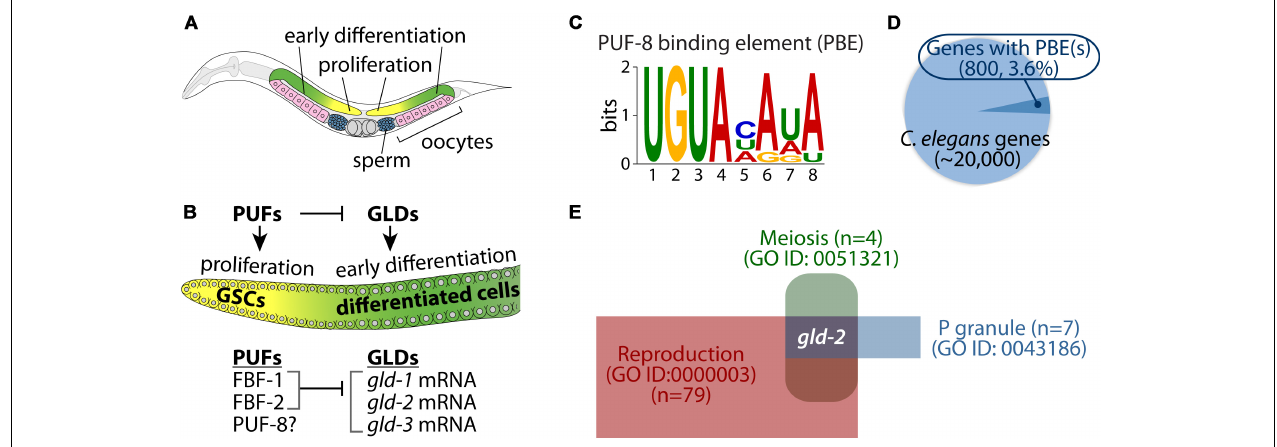
FIGURE 1 | Caenorhabditis elegans germ line and PUF-8 RNA-binding protein. (A) Schematic of an adult C. elegans hermaphrodite gonad. Cells at the distal end of the germline include germline stem cells (GSCs) and proliferative cells (yellow). As cells move proximally, they enter meiosis (green) and differentiate into either sperm (blue) or oocytes (pink). (B) Key RNA-binding proteins that control a balance between proliferation and differentiation. PUFs proteins (e.g., FBF-1/2) promote germ cell proliferation by inhibiting GLDs (e.g., GLD-1/2/3)-mediated germline differentiation (Kimble and Crittenden, 2002). However, PUF-8 controls both proliferation and differentiation, depending on genetic context (Datla et al., 2014). (C) Consensus sequence of PUF-8 binding element (PBE). (D) Pie chart of potential PUF-8 target genes (800, 3.6%) that contain at least one PBE. (E) Identification of gld-2 as a potential PUF-8 target mRNA involved in three gene ontology (GO)